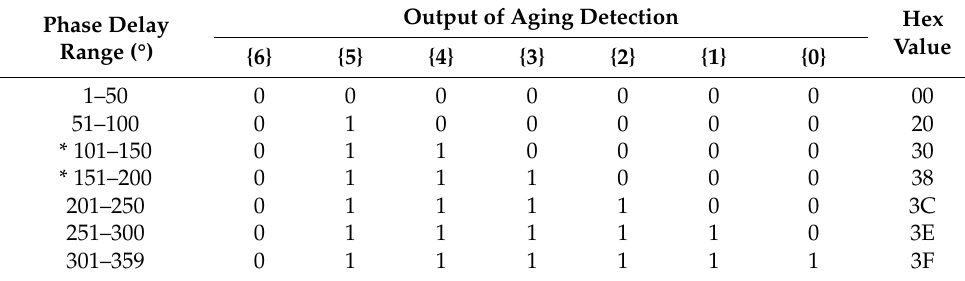
Table 2. Output of aging detection using exhaustive